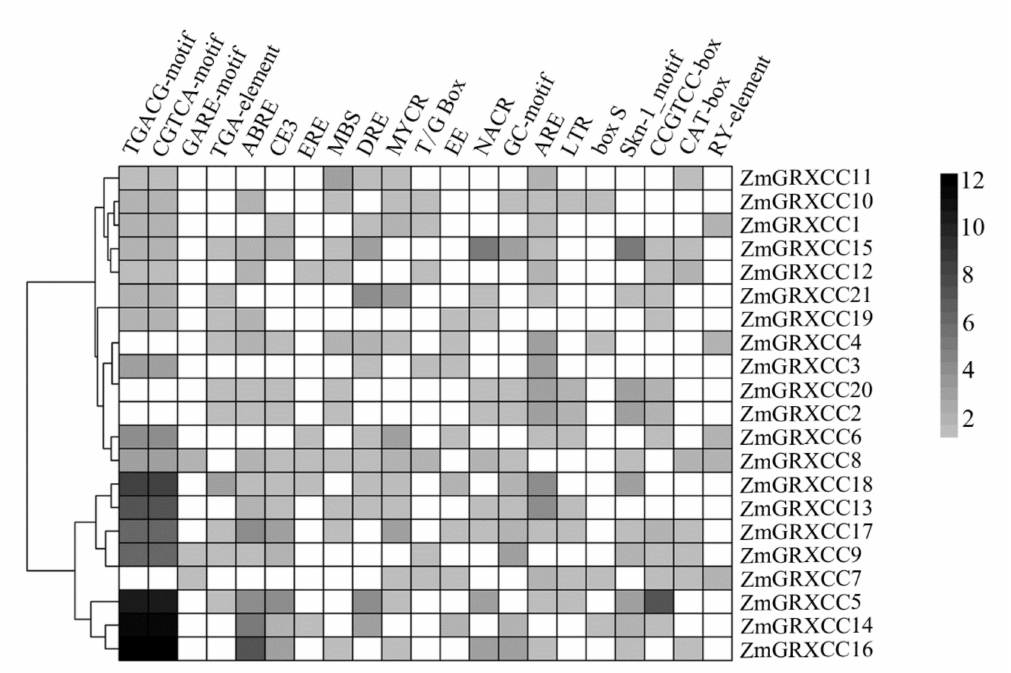
Figure 4. Cis -regulatory elements identified in the ZmGRXCC promoters. The 1.5 kb regions upstream of the translation start codons of the ZmGRXCC genes were used to search for putative cis -regulatory elements using the plant cis -acting regulatory DNA elements. The chart was drawn based on the presence and number of cis -regulatory elements that are responsive to specific elicitors or conditions. The color scale ranged from gray, representing minimum number of insertion, and finally to black, representing maximum number of insertion. The white color shows missing